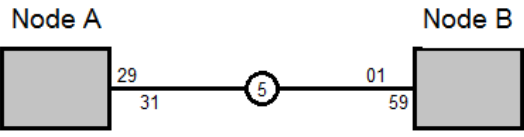
Figure 9. Five intermediate stops between nodes A and B, the number of grouped stops is indicated with a numeric descriptor in an empty circle.